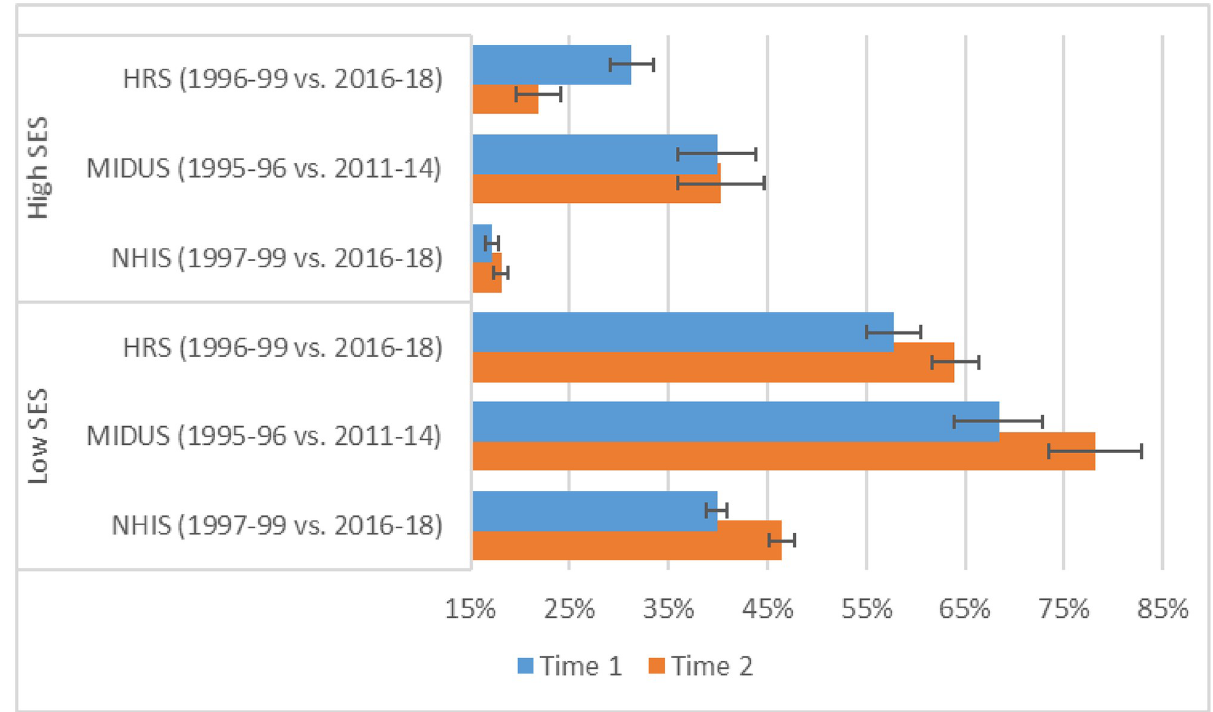
Fig 9. Predicted prevalence of any physical limitation at age 50 by survey and period for low versus high SES. These predicted probabilities were based on models that adjusted for sex, age (quadratic specification), race/ethnicity, period (categorical specification), and SES. The models included the following 2-way interactions: age (quadratic) x period; age (quadratic) x SES; and period x SES. They also included a 3-way interaction between age (linear), period, and SES. We computed the probabilities for someone aged 50 at the 10th (low SES) vs. the 90th (high SES) percentiles of SES for the specified periods; all other covariates were fixed at the values observed in the